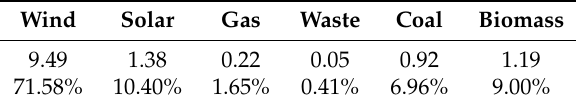
Figure 3. Global state of charge for the non-aggregated test case. Table 4. Share of dispatched energy by carriers (TWh).